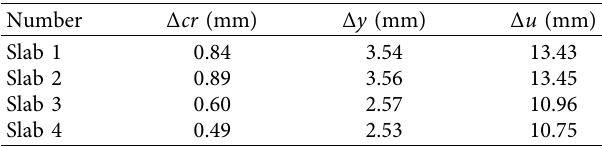
Figure 8: Cracks development diagram in the top of and at bottom of Slab 1–Slab 4: (a) bottom of Slab 1; (b) top of Slab 1; (c) bottom of Slab 2; (d) top of Slab 2; (e) bottom of Slab 3; (f) top of Slab 3; (g) bottom of Slab 4; (h) top of Slab 4. Table 4: Eigenvalue of deflection of the